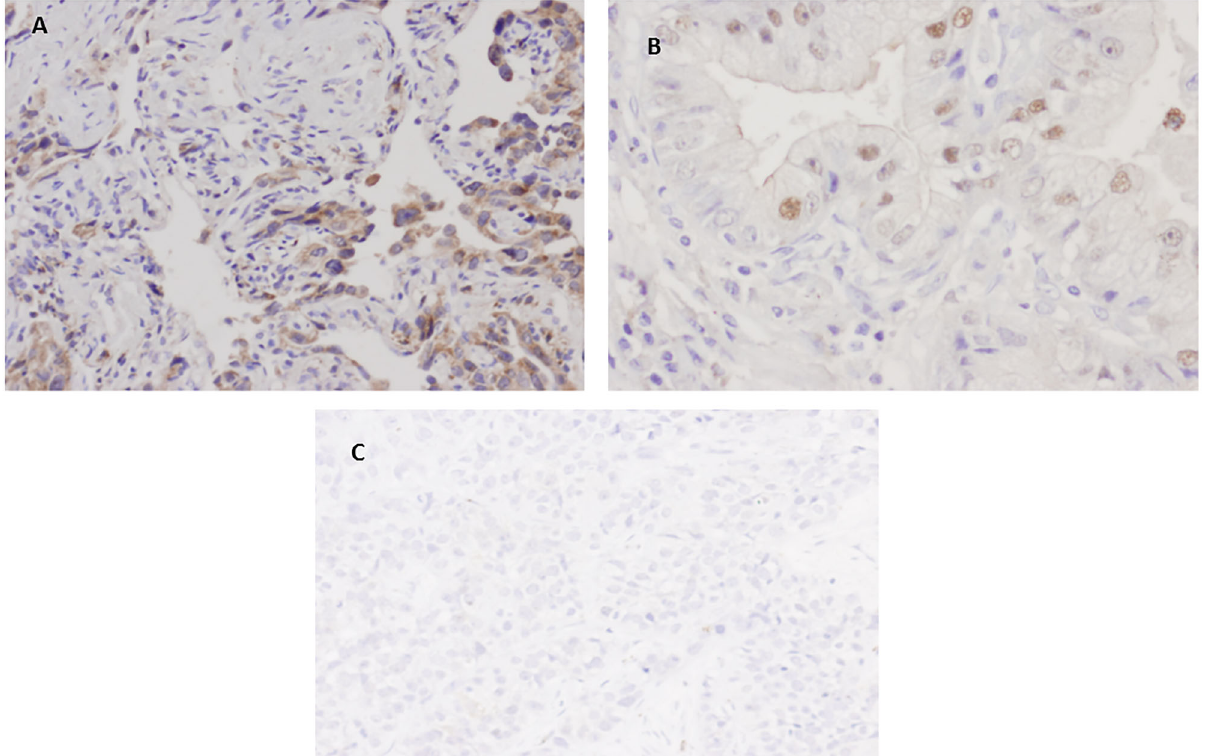
Figure 2. Immunohistochemical staining of PKP1 in AC. (A and B) Weak cytoplasmic and nuclear staining (40 (cid:5) ). (C) Poorly differentiated AC with completely nega- tive staining (10 (cid:5)